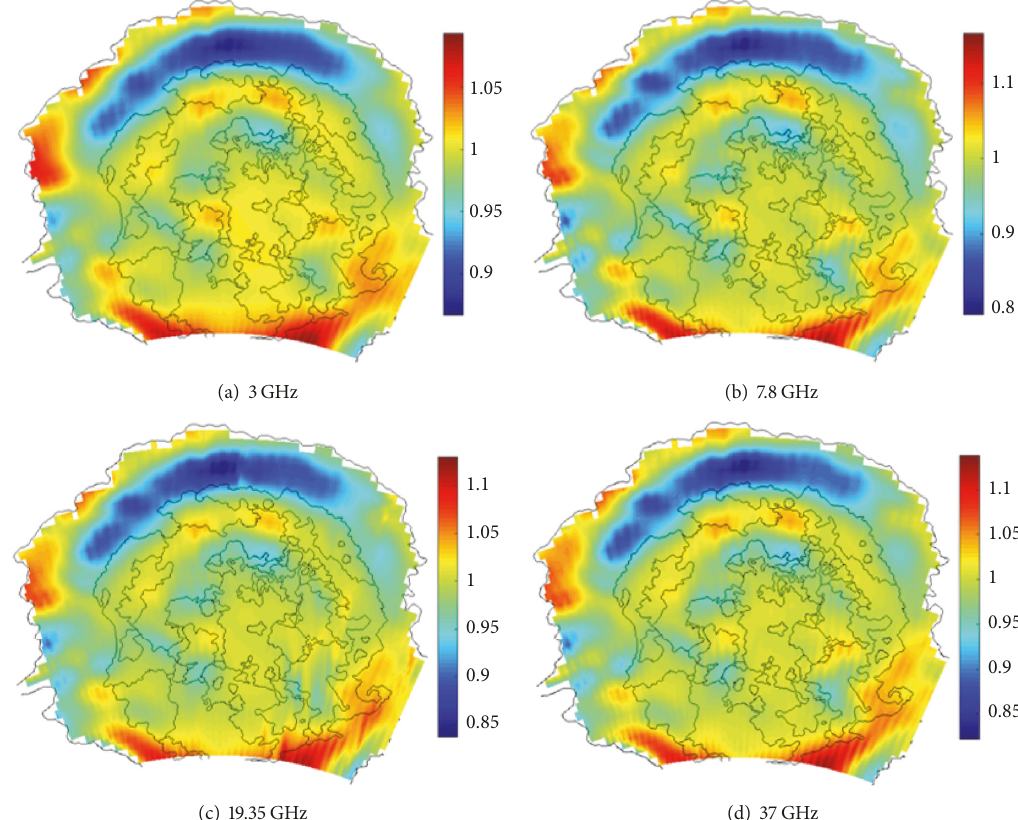
Figure 8: n T maps of the Schr¨odinger basin at 0 o’clock. B